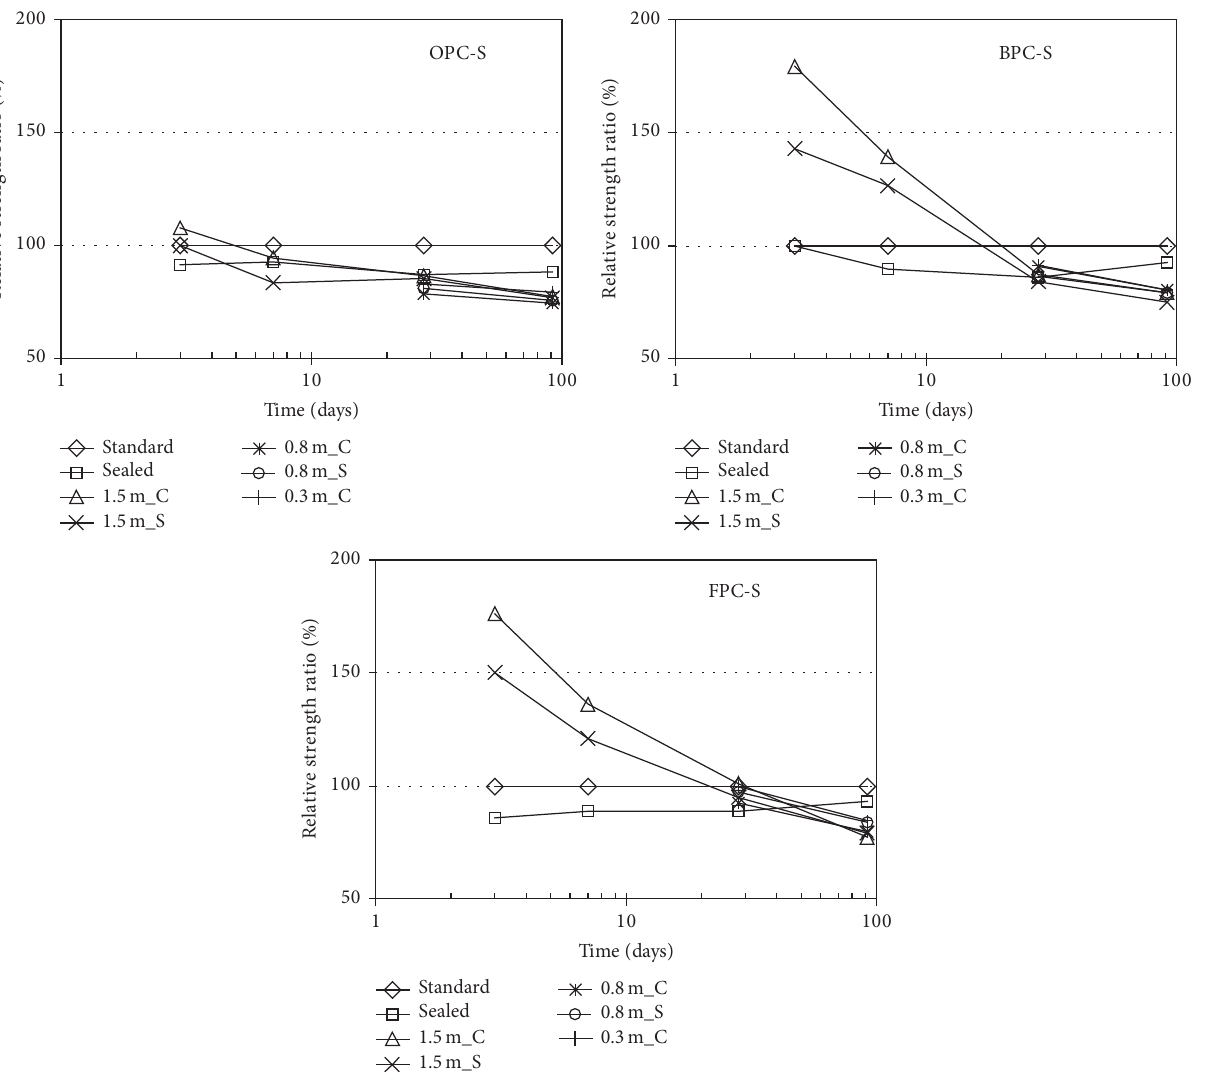
Figure 3: Effect of temperature on strength development of concrete at